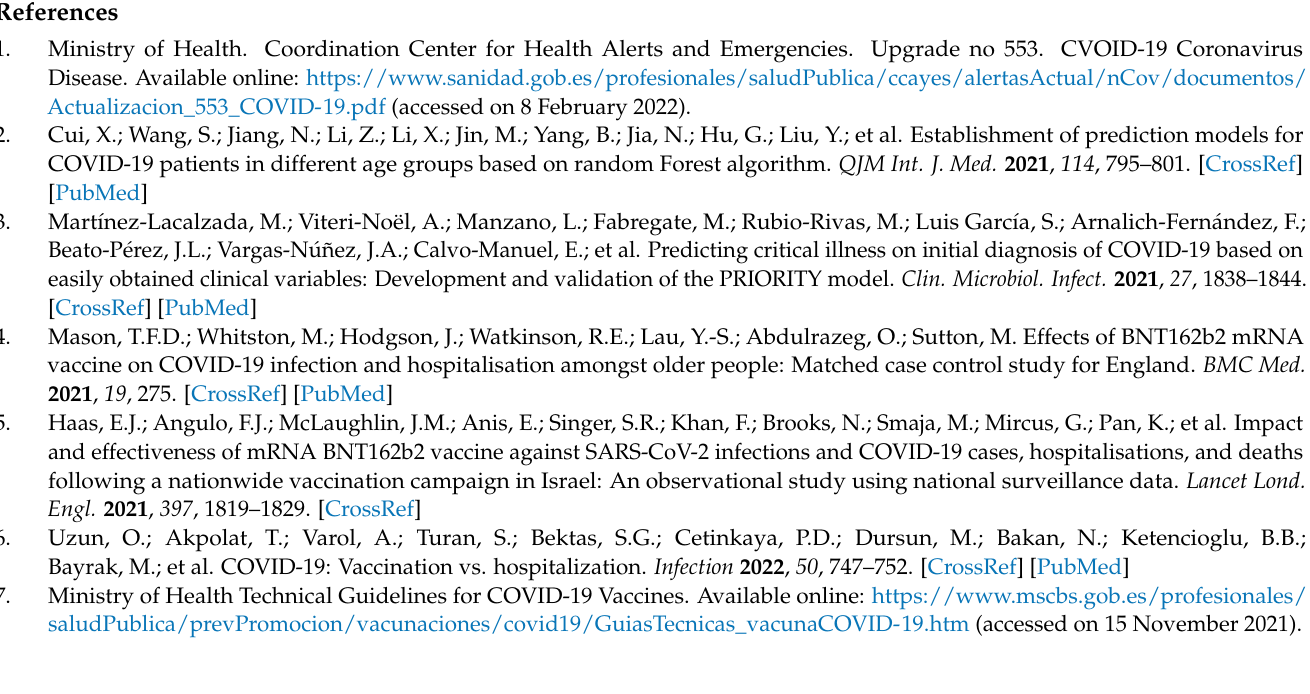
Figure S2: Calibration plot of mortality model; Figure S3: Linear regression model residuals